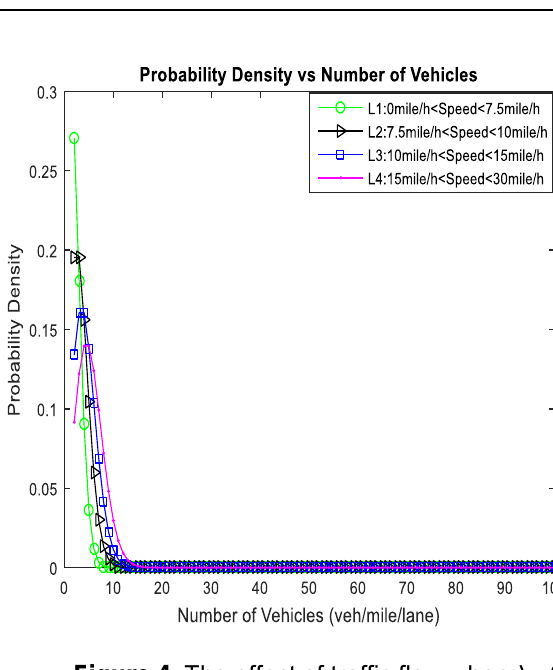
Figure 3. The effect of traffic flow when λ =1 Figure 4. The effect of traffic flow when λ =2